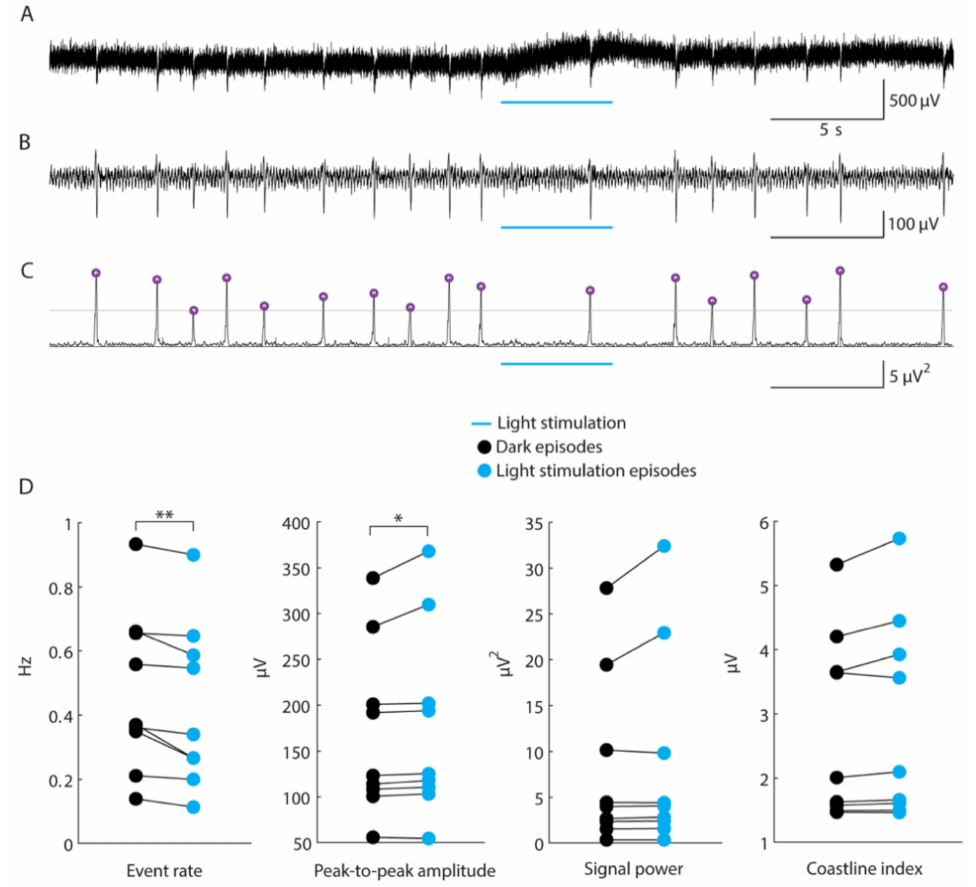
Figure 9. Light-induced activation of grafted hdInts reduces the rate of induced epileptiform dis- charges. ( A ) Example of a raw local field potential (LFP) recording with epileptiform discharges. ( B ) Filtered LFP trace. ( C ) Power of the filtered signal calculated in 50 ms windows shifted sample by sample. Grey horizontal line marks the detection threshold while purple circles mark the detections. ( D ) Parameters of the epileptiform discharges during dark periods and during light stimulations. *, p < 0.05; **, p < 0.01. The Wilcoxon signed-rank test was used for comparisons in ( D